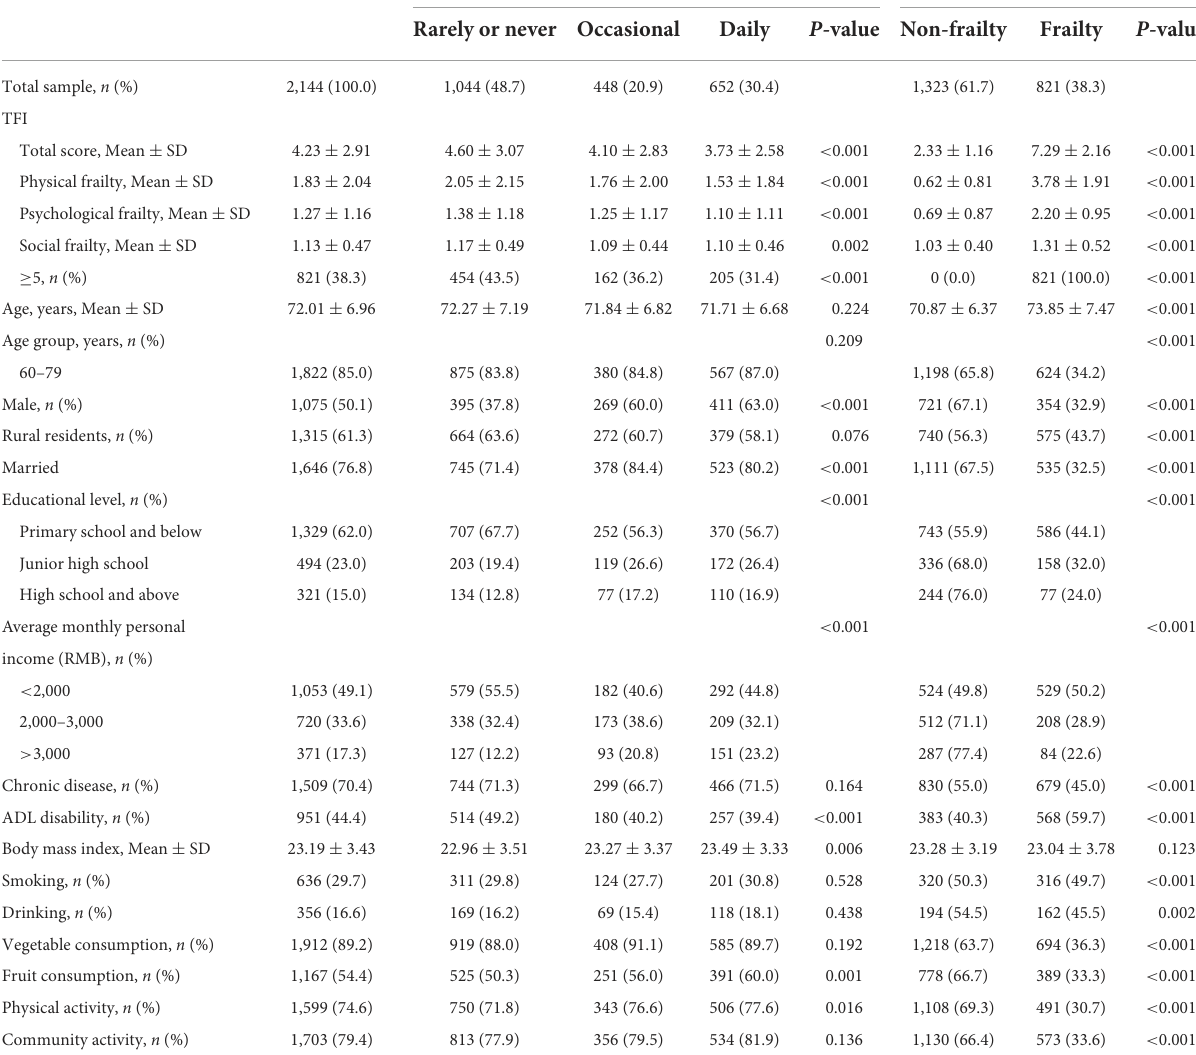
TABLE 1 Descriptive statistics of participants’